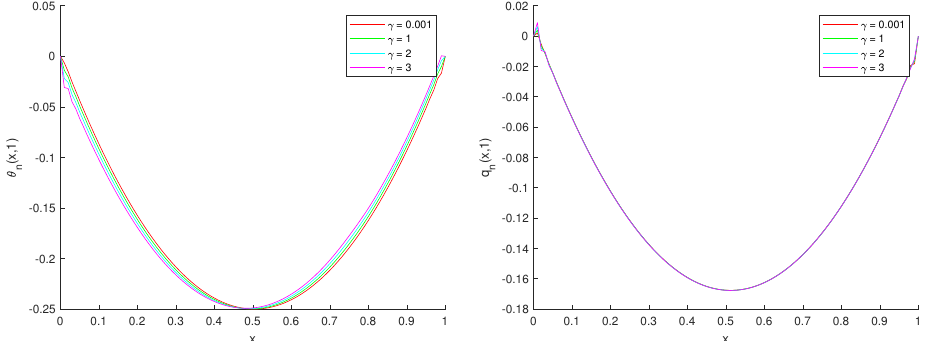
Figure 5. Example 2: temperature and heat flux for different values of parameter γ